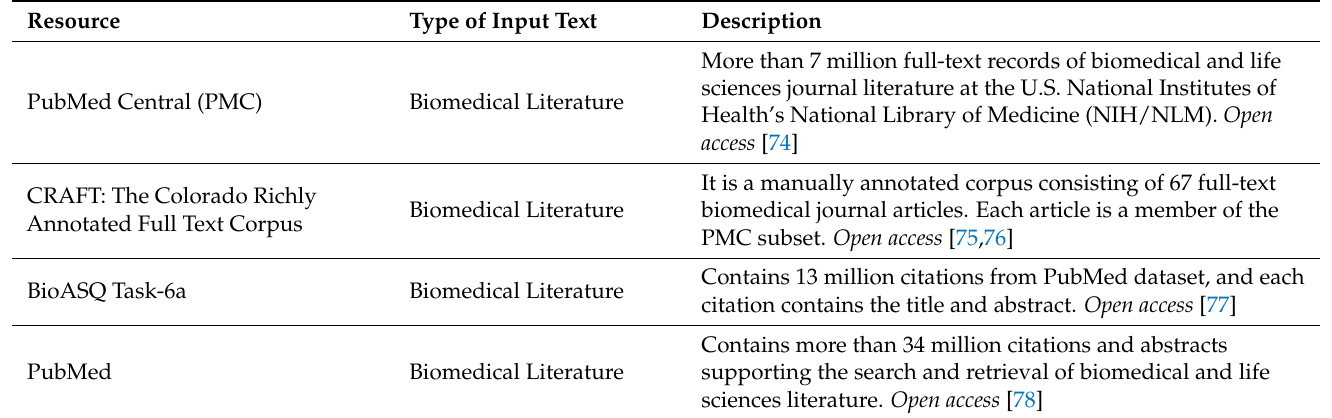
Table A1. Datasets of biomedical resources for summarization